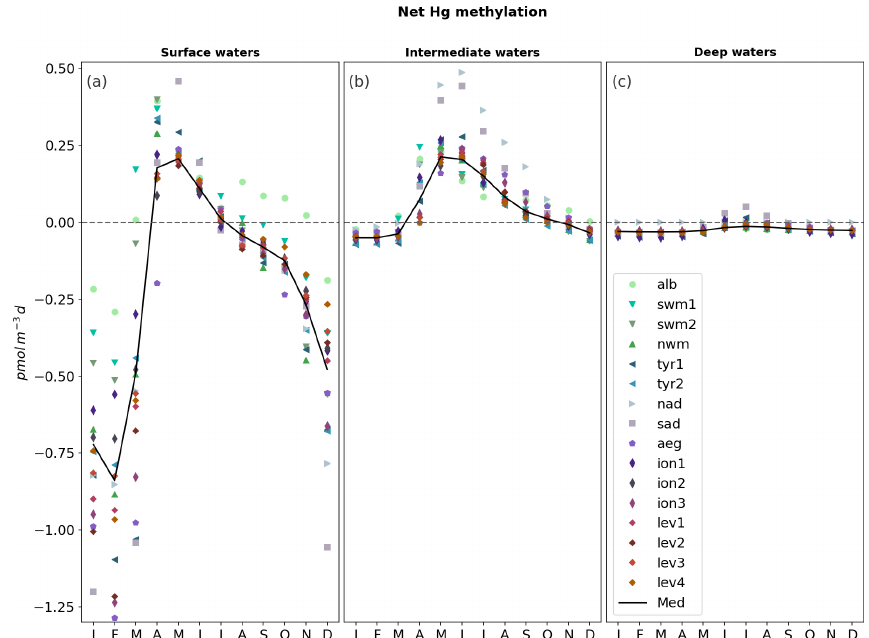
Figure 6. Monthly evolution of the net methylation fluxes (pmolm − 3 d − 1 ) for each subbasin (colored markers) of the Mediterranean Sea (black lines) depth-integrated for (a) surface water (0–100m depth), (b) intermediate water (100–600m depth), and (c) deep water ( > 600m depth). Net methylation is calculated as the difference between modeled Hg methylation fluxes and demethylation fluxes (both dark and photochemical).